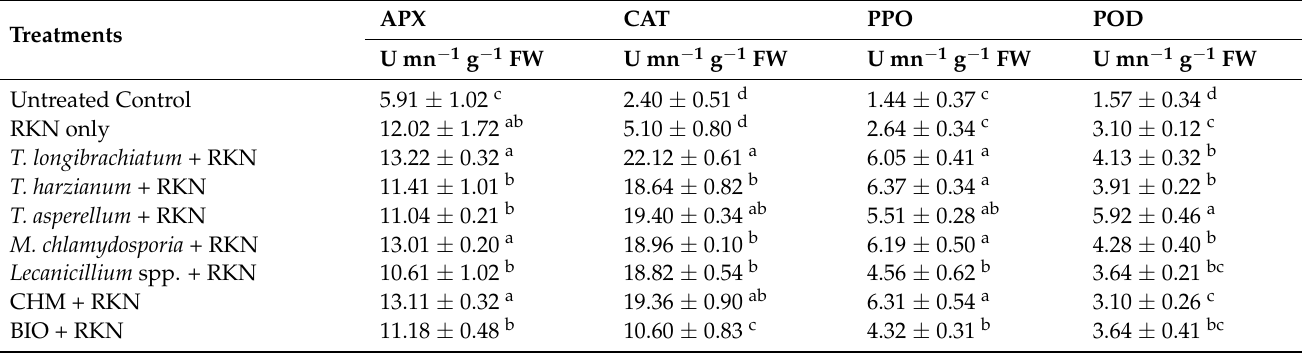
Table 3. Activity of antioxidant enzymes: ascorbate peroxidase (APX), peroxidase (POD), polyphenol- oxidase (PPO), and catalase (CAT) in tomato plant roots 7 days after M. javanica inoculation.